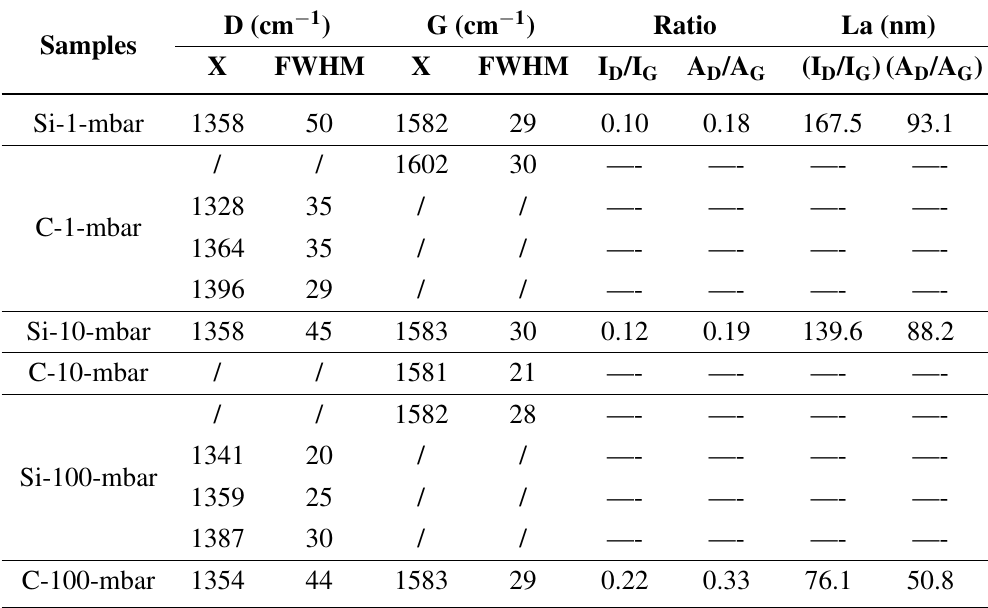
Table 1. Results of Lorentz fits and grain sizes calculation for EG on polar faces of 4H-SiC